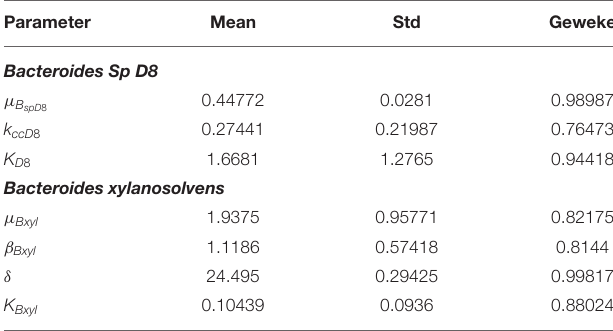
TABLE 1 | MCMC parameter estimation